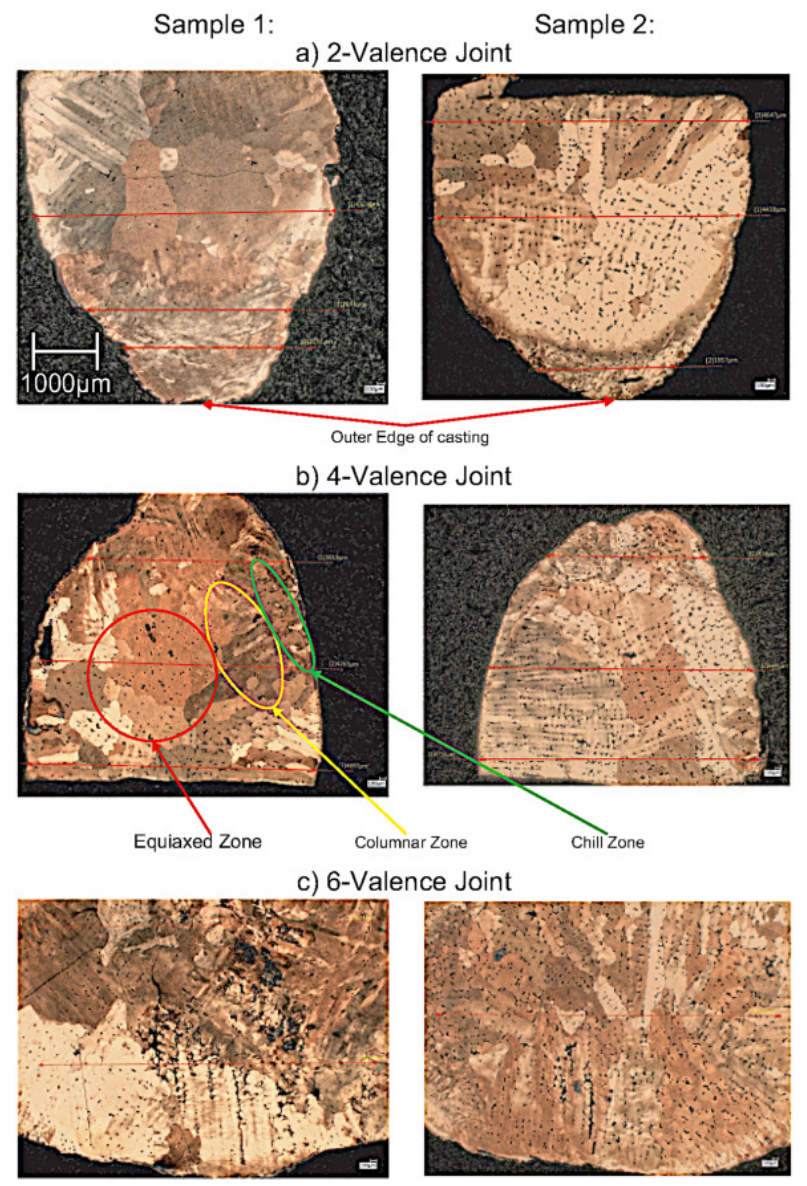
Figure 12. Grain structure analysis using optical microscopy. Images 50 ×